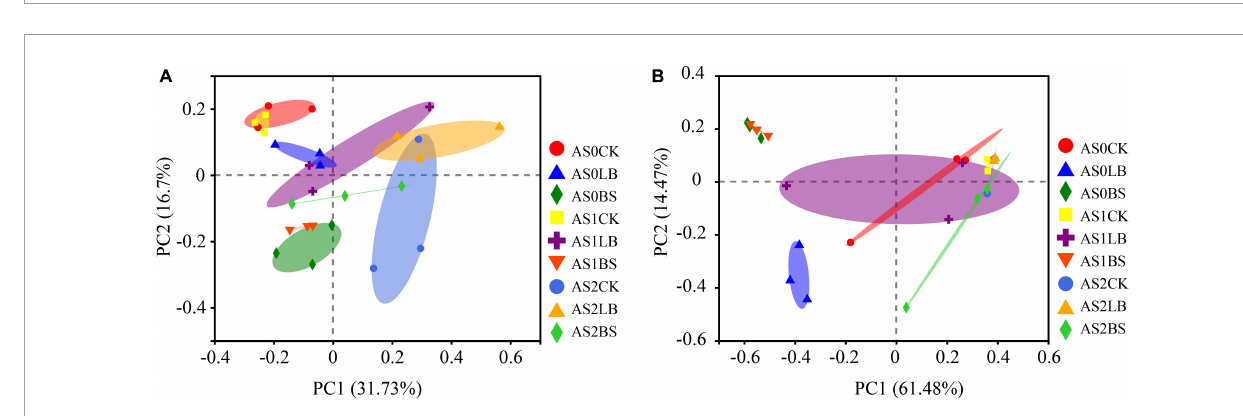
FIGURE5 Principal component analysis of bacterial communities (A) and fungal (B) operational taxonomic units (OTUs) in whole plant corn silage during aerobic exposure. AS0CK, not inoculated silage at 0 h of aerobic exposure; AS0LB, Lentilactobacillus buchneri inoculated silage at 0 h of aerobic exposure; AS0BS, inoculated Bacillus subtilis silage at 0 h of aerobic exposure; AS1CK, not inoculated silage at 18 h of aerobic exposure; AS1LB, Lentilactobacillus buchneri inoculated silage at 18 h of aerobic exposure; AS1BS, inoculated Bacillus subtilis silage at 18 h of aerobic exposure; AS2CK, not inoculated silage at 60 h of aerobic exposure; AS2LB, Lentilactobacillus buchneri inoculated silage at 60 h of aerobic exposure; AS2BS, inoculated Bacillus subtilis silage at 60 h of aerobic